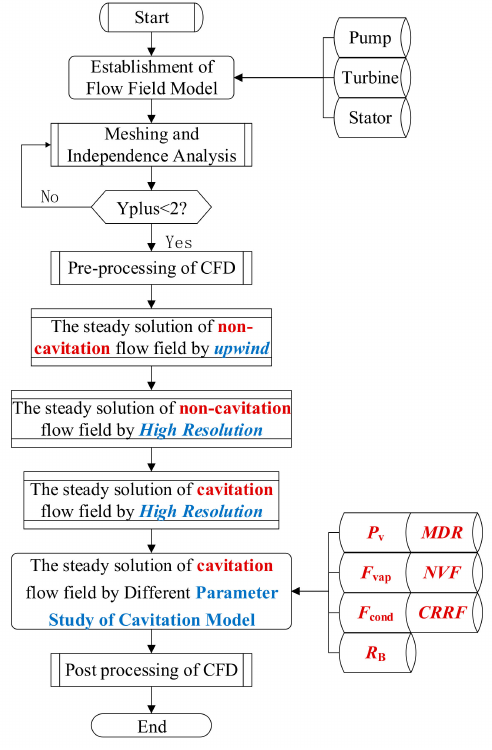
Figure 4. Flow chart for the torque converter cavitation calculation using